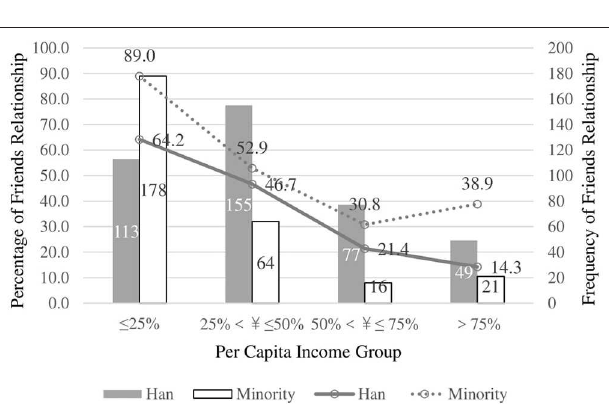
likely to approach friend relationships in rural areas than in urban hospitals.